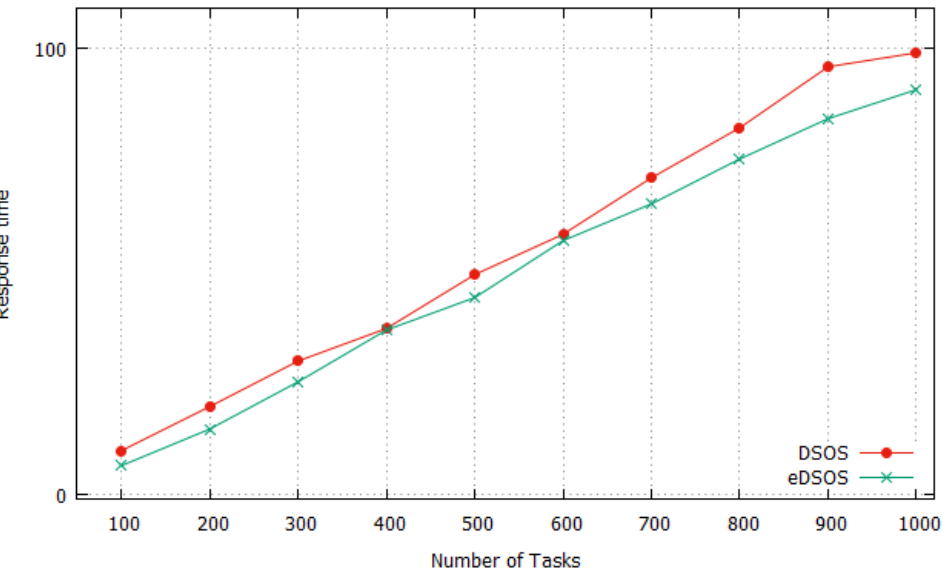
Figure 9. Response time for dataset with the right-half